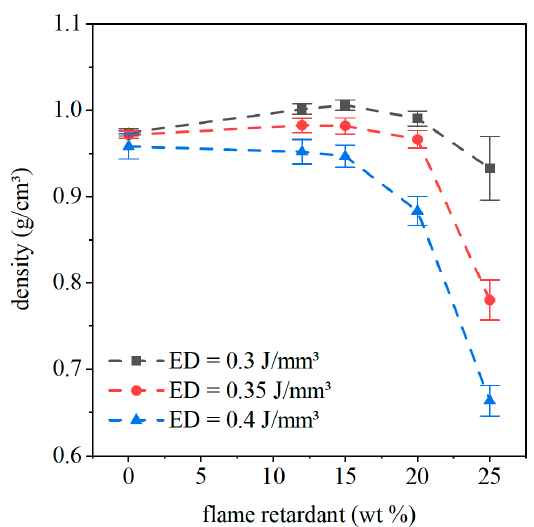
Figure 10. The density of the laser-sintered specimen for different flame retardant concentrations and energy densities.